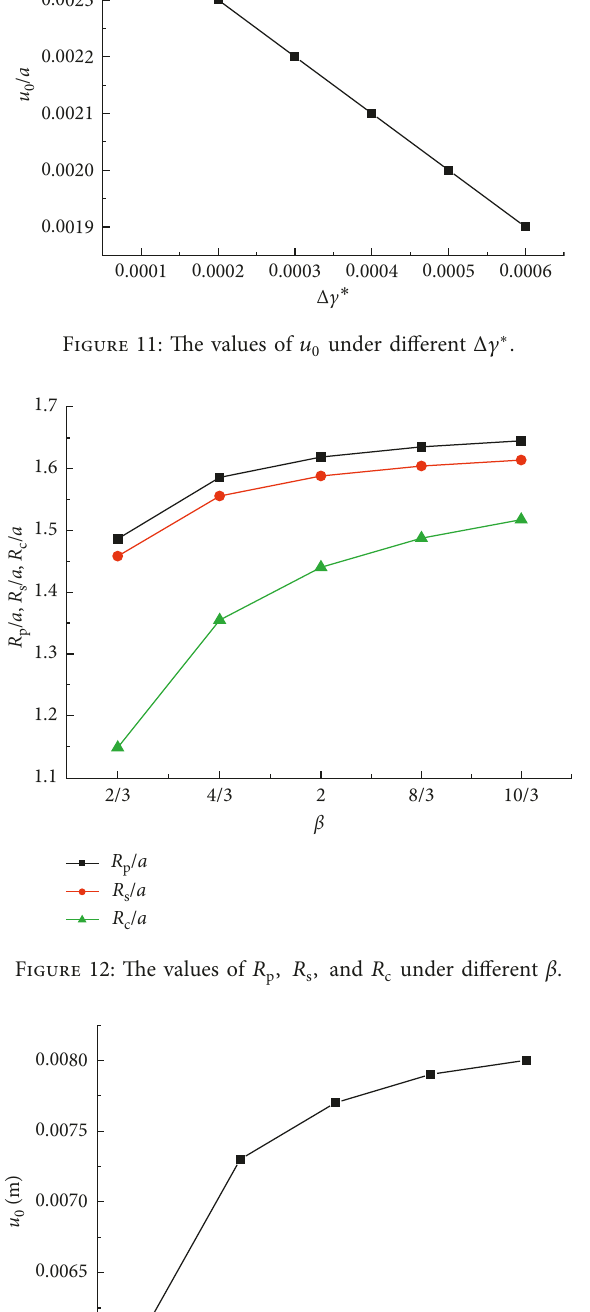
0 under different β